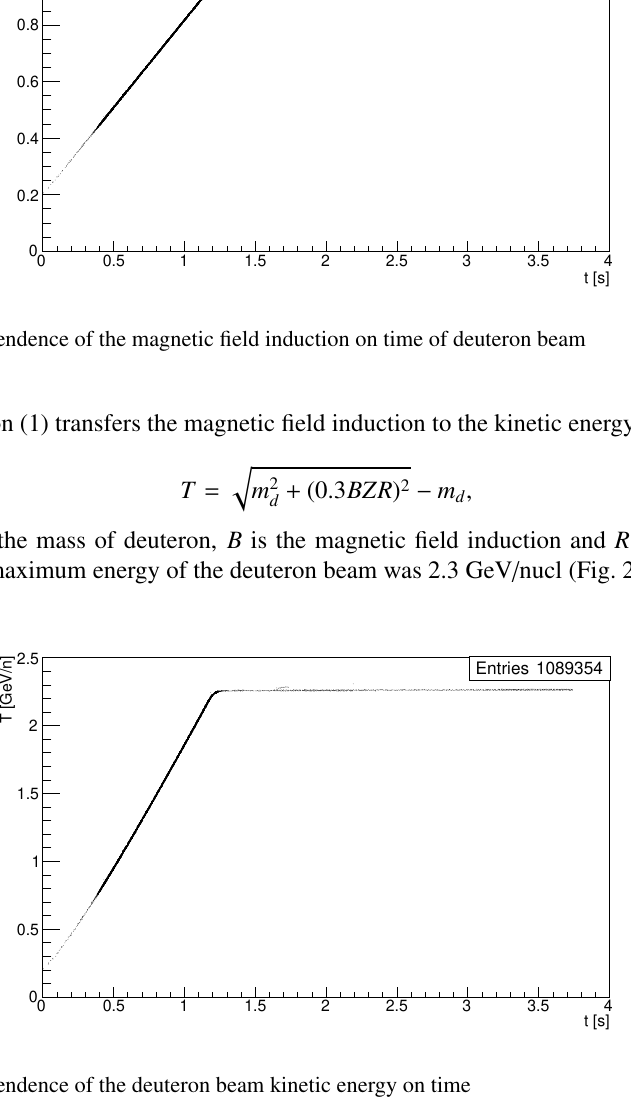
The energy spectra of secondary protons for the di ff erent energies of primary deuterons T d were calculated. An example of these spectra is shown in Fig. 3. The proton from